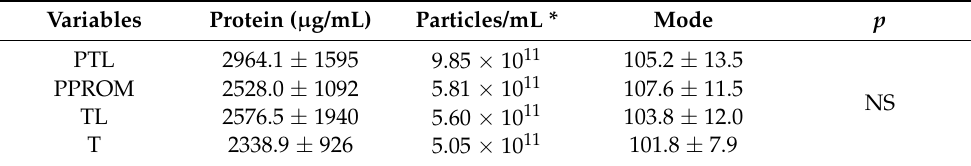
Figure 1. sEV characterization by nanotracking particle analysis—size distribution and concentration of small extracellular vesicles (sEV) isolated from plasma—and Western blotting for the exosome marker CD63. Table 3. Comparison of protein quantification and nanoparticle tracking analysis data.